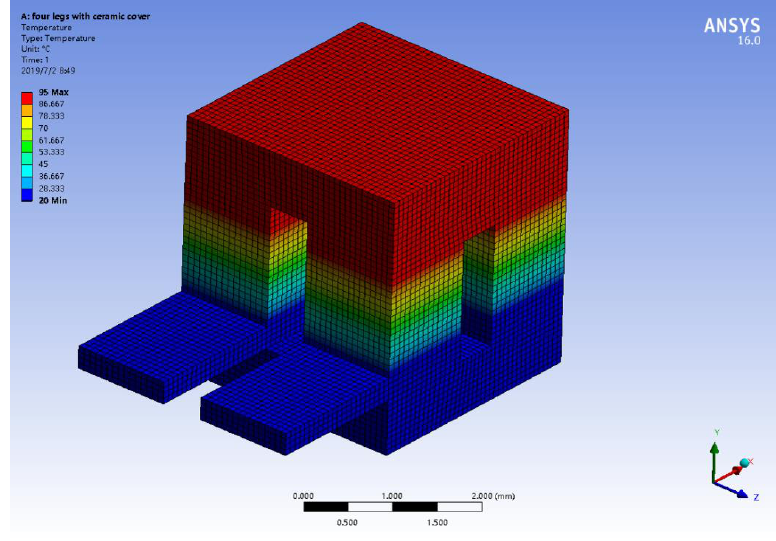
Figure 4. Steady state temperature distribution of thermoelectric system.